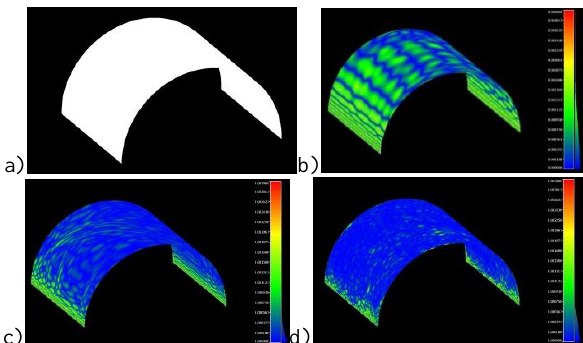
Figure 7. Results for a synthetic barrel vault with a unique layer: (a) original point cloud; (b) result with 20 neurons; (c) results with 100 neurons; and (c) results with 200 neurons (color scale is the same for images b-c-d).